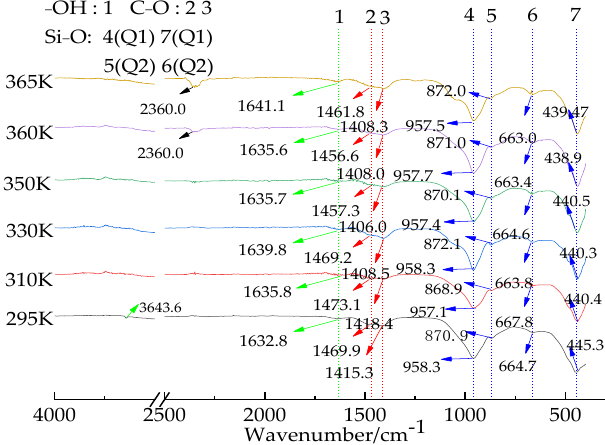
Figure 6. Infrared spectrum of the products at different temperatures. The TG curves of the porous calcium silicate are shown in Figure 7, indicating that microporous calcium silicate had three stages of weight loss from room temperature to 1470 K. The first stage of weight loss occurred between 320 K and 570 K, and the weight loss rate was about 12–15%, which was mainly caused by a small amount of free water in the raw material and the removal of crystal water in the structure. In this temperature range, a large endothermic peak appeared on the differential scanning calorimetry curve (DSC curve) around 400 K corresponding to it. At this time, the crystal of the sample had not changed, and its main components were still amorphous. In the range of 570~1070 K, the weight loss of the second stage occurred, and the weight loss rate was about 5–7%, as a part of Ca(OH) 2 in the sample absorbs CO 2 in the air and turns into calcium carbonate, and the decomposition of CaCO 3 and the residual Ca(OH) 2 in the sample are endothermic decomposed into CaO and H 2 O. In this temperature range, the bond fracture of Si–OH resulted in the transformation of dehydrated microporous calcium silicate into calcium silicate without –OH(Ca 6 Si 6 O 18 ). These three reasons together caused the TG curve in the range of 870~970 K to show obvious weight loss, while the dehydrated calcium silicate showed an endothermic reaction during dehydroxylation, leading to a relatively weak endothermic peak in the differential scanning calorimetry curve (DSC curve) at about 970 K. The thermogravimetric curve (TG) was relatively flat after 1070 K, indicating that